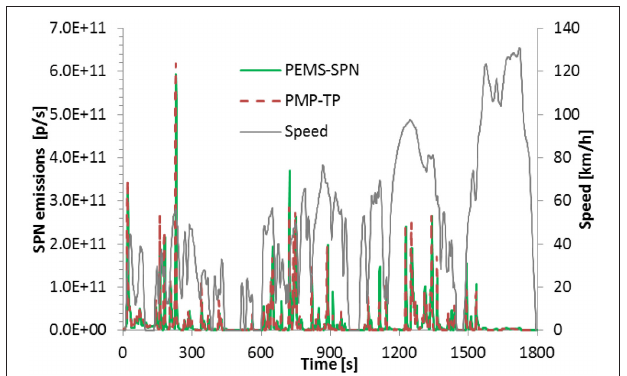
FIGURE 4 | SPN emissions of Vehicle DPF#1 over the distance between regenerations. Each point represents a phase of a test cycle (mix of NEDCs and WLTCs). Cold-start cycles are indicated by black border line. All tests were conducted in the laboratory with PMP-CVS equipment. Sequence #3 was stopped before